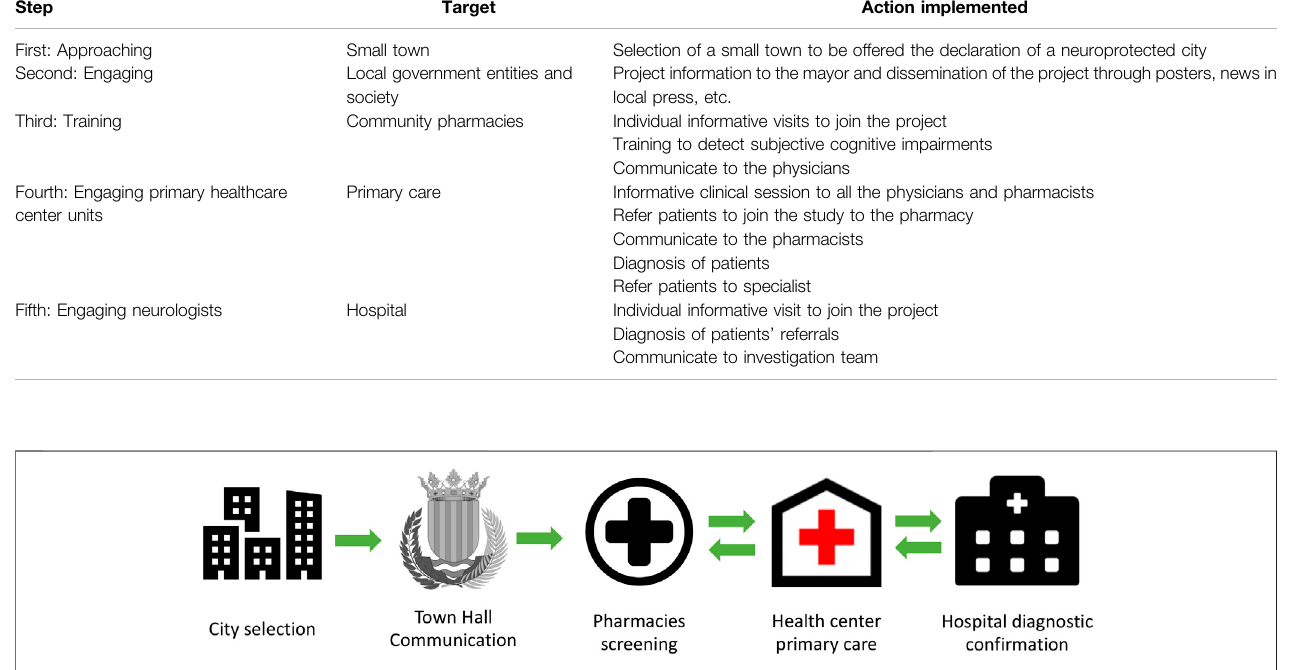
Frontiers in Pharmacology |